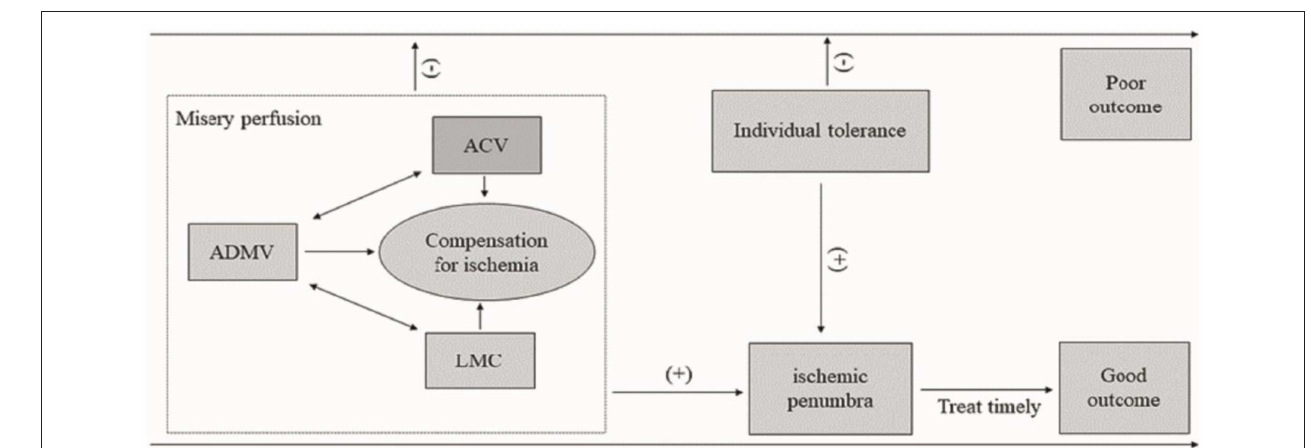
FIGURE 6 | Diagram of the influence of ADMV, ACV, LMC, and ischemic tolerance on clinical outcome of acute occlusion of a large cerebral artery. An increased OEF (ADMV, ACV) and a good leptomeningeal collaterals (HVS) resulted in a misery perfusion. A misery perfusion and individual tolerance are positive for ischemic penumbra, and then a timely and successful recanalization to save the at-risk brain tissue may lead a good prognosis. Otherwise, the prognosis is poor. ADMV, asymmetric deep medullary veins; ACV, asymmetric cortical veins; LMC, leptomeningeal collateral; ( − ), negative or poor; ( + ), positive or good.